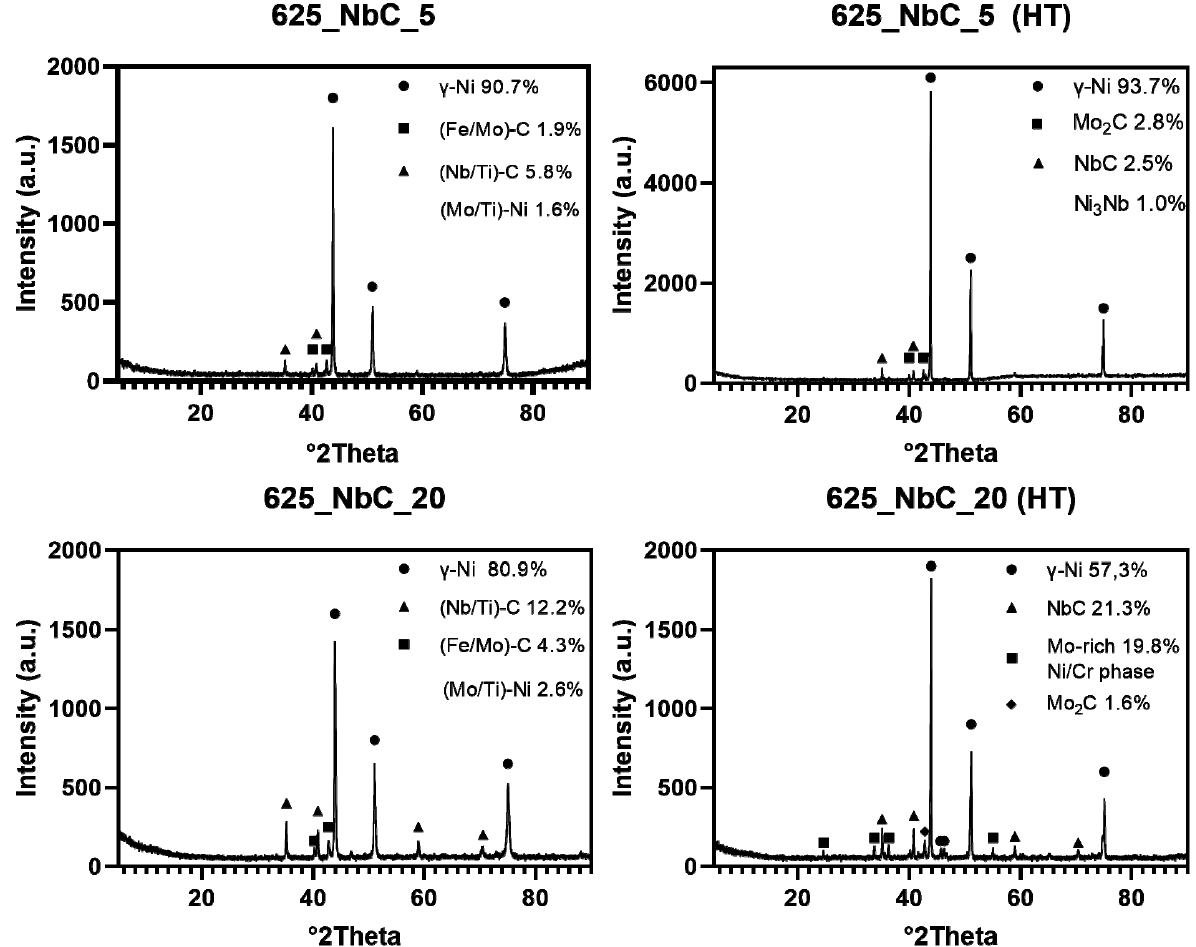
Figure 9. XRD patterns of chosen Inconel 625-NbC samples and phase quantification. HT stands for “heat-treated”. Phases without a symbol where found in the material without clear, separate peak by analysis process provided in the software.